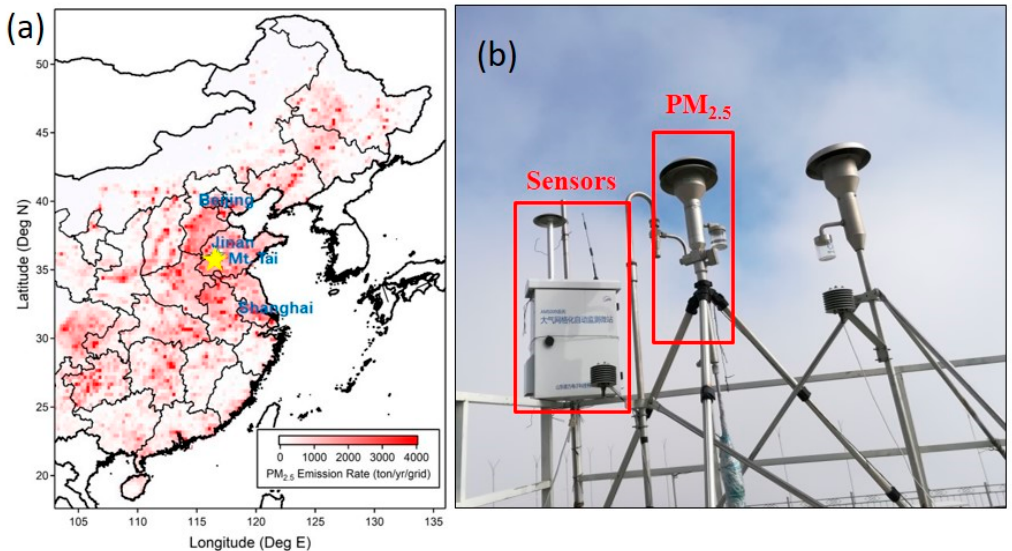
Figure 1. ( a ) Map showing the location of Mt. Tai. The emission data of fine particulate matter (PM 2.5 ) were downloaded from http://meicmodel.org/about.html. ( b ) Photo of the sampling inlets of the air quality sensor and benchmark instruments on the rooftop of Mt. Tai station.